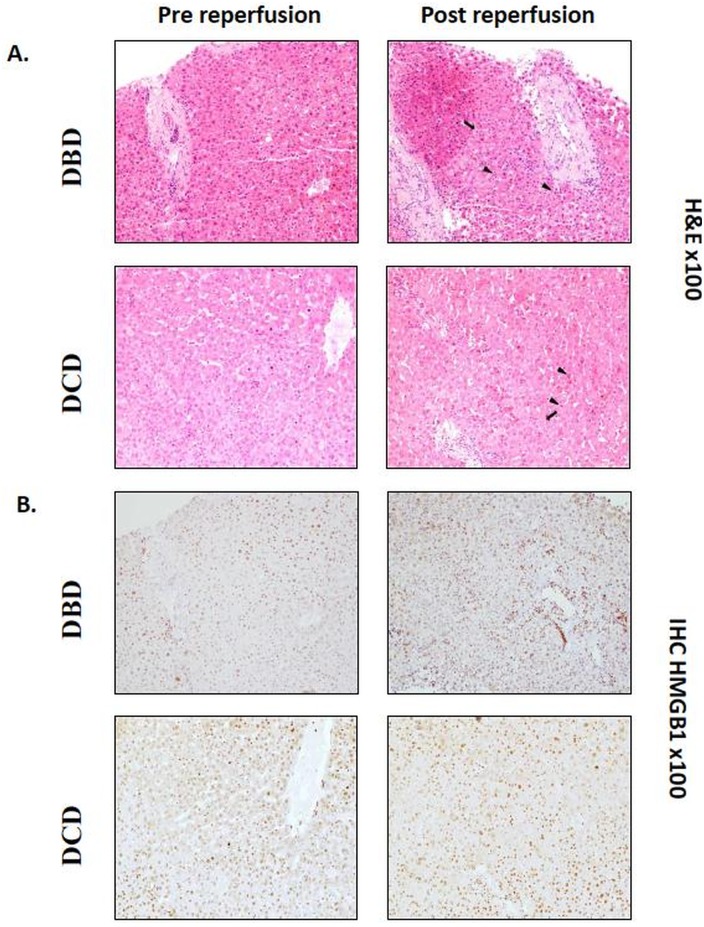
Intrahepatic T-cells respond to HMGB1 in vitro.(A, B) Biopsies obtained from liver allografts before (left) and one-hour after (right) reperfusion. (A) Haematoxylin and eosin staining of a representative biopsy from DBD or DCD livers showing hepatocellular necrosis (plain arrow) and neutrophil aggregation (arrowhead) in post-reperfusion samples; (B) Immuno-histochemical staining for HMGB1 of the biopsies shown in (A) reveals an increased proportion of hepatocytes showing nuclear expression of HMGB1 in post-reperfusion samples compared to the pre-reperfusion counterparts but no cytoplasmic expression; (C) Production of IFN-γ from T-cells of a representative donor co-cultured with syngeneic DC at the ratio of 20:1 for 7 days. Percentage of IFN-γ-producing cells gated on CD8+CD3+ T-cells in unstimulated cultures (negative control), in presence of anti-CD3/CD28 (positive control) or in presence of HMGB1 at 100ng/ml; (D) Proliferative response of T-cells in unstimulated cultures (negative control), in presence of anti-CD3/CD28 (positive control) or in presence of HMGB1 at 100ng/ml. 1 = negative, 3 = positive control and 2 = HMGB1; (E) Quantitative analysis of IFN-γ concentration in supernatants of cultures. NT = negative control, S = aCD3/CD28 stimulation, HMGB1 = cultures stimulated in presence of 100 or 10ng/ml of HMGB1. Depiction of IFN-γ concentration in pg/ml (left) and ratio of increase reported to the negative control (right). Kruskal Wallis test was used.